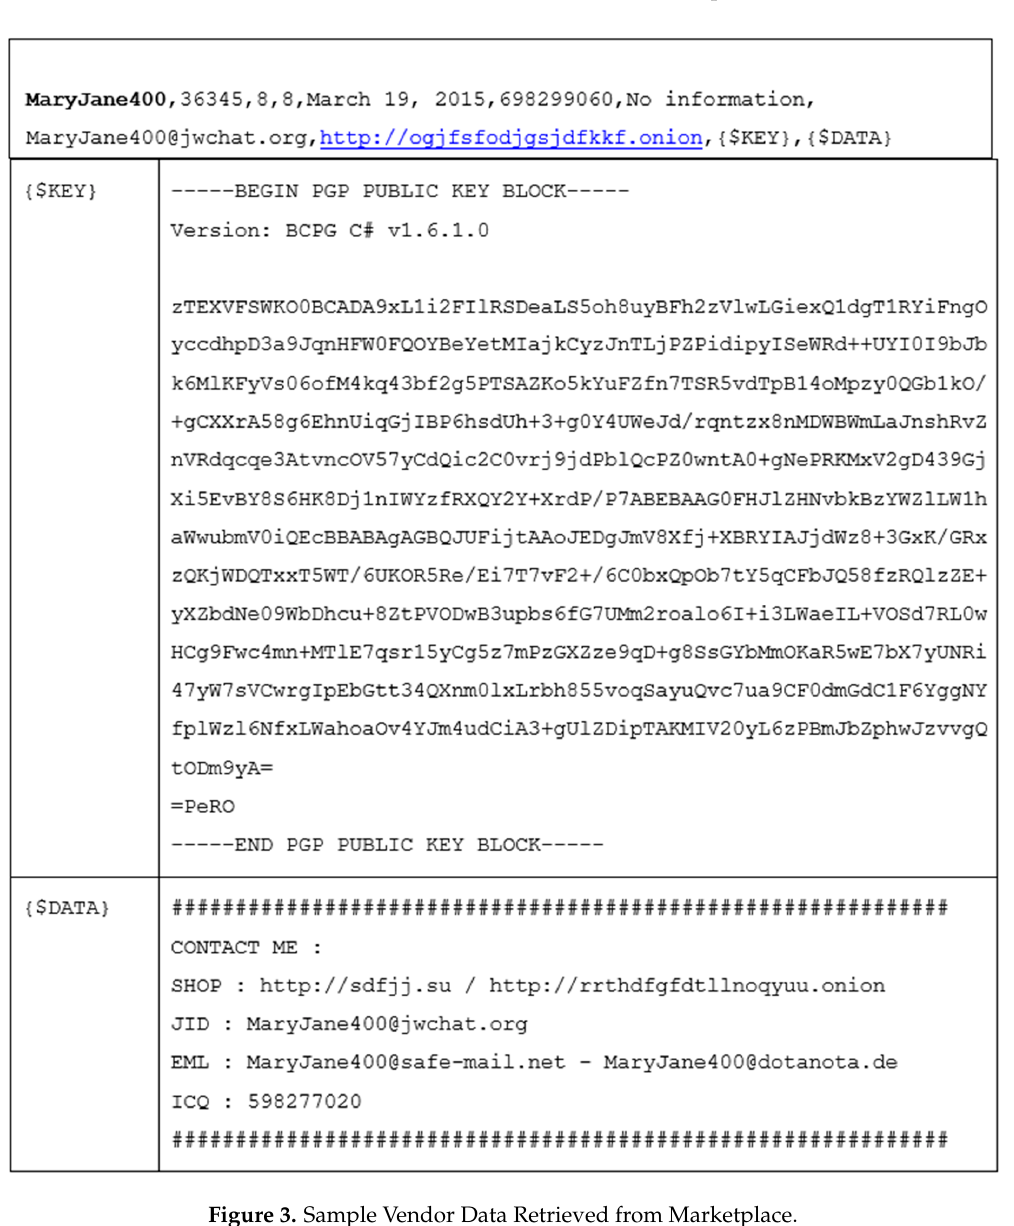
Figure 2. Structure of Vendor Data from Marketplace.